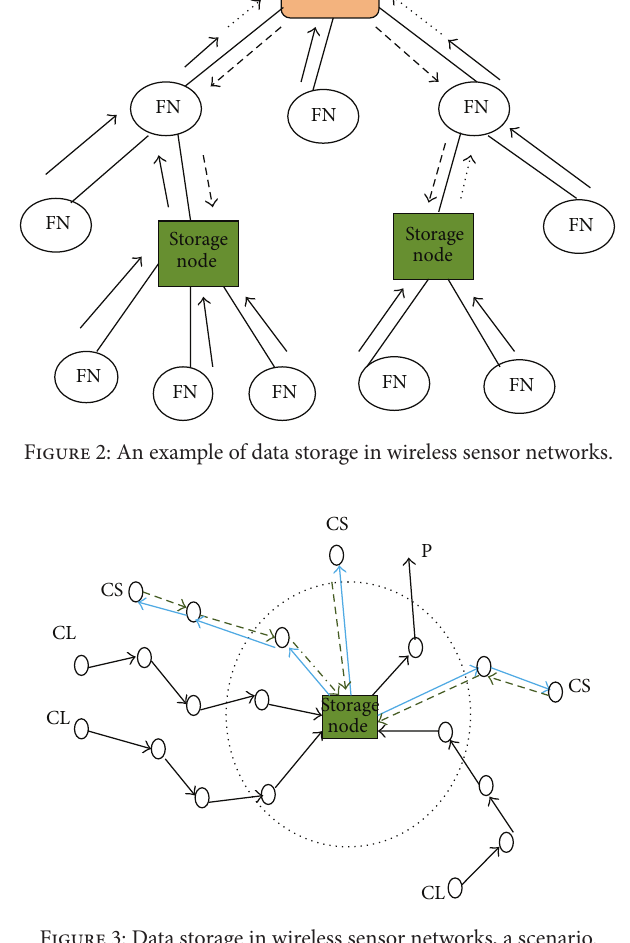
Figure 3: Data storage in wireless sensor networks, a